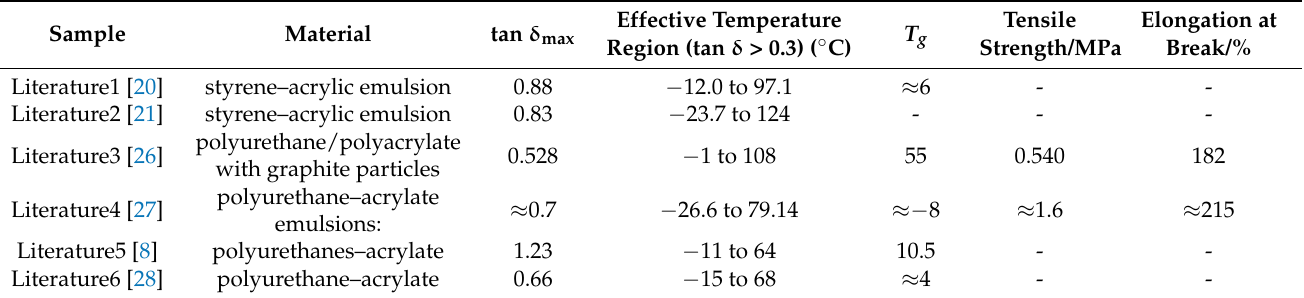
Table 1. The results of the